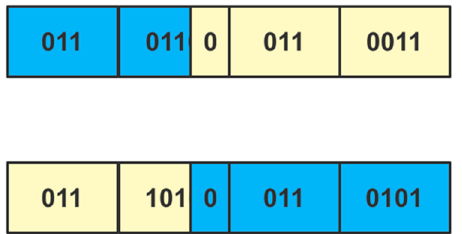
Figure 10. Two new alarm records after a crossover operation.